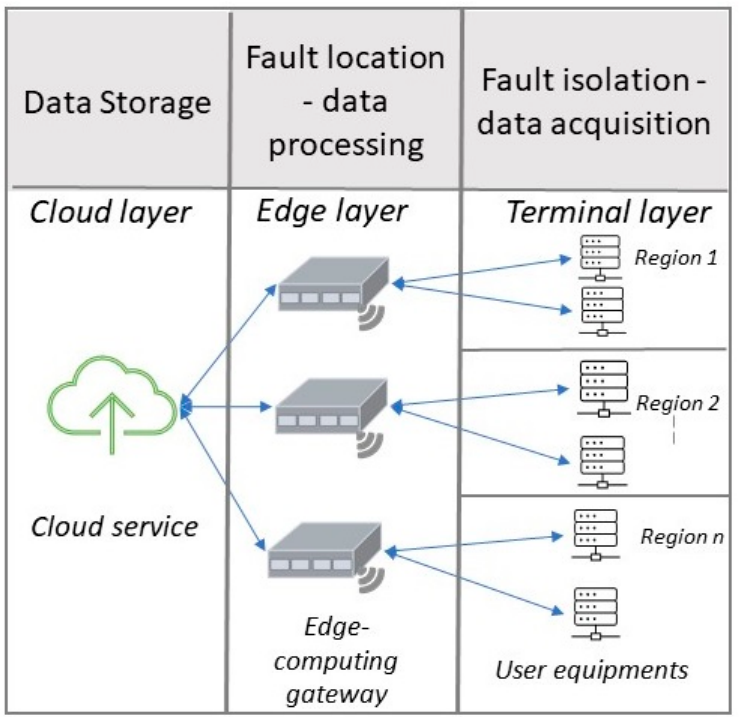
Figure 10. Hierarchical fault monitoring system